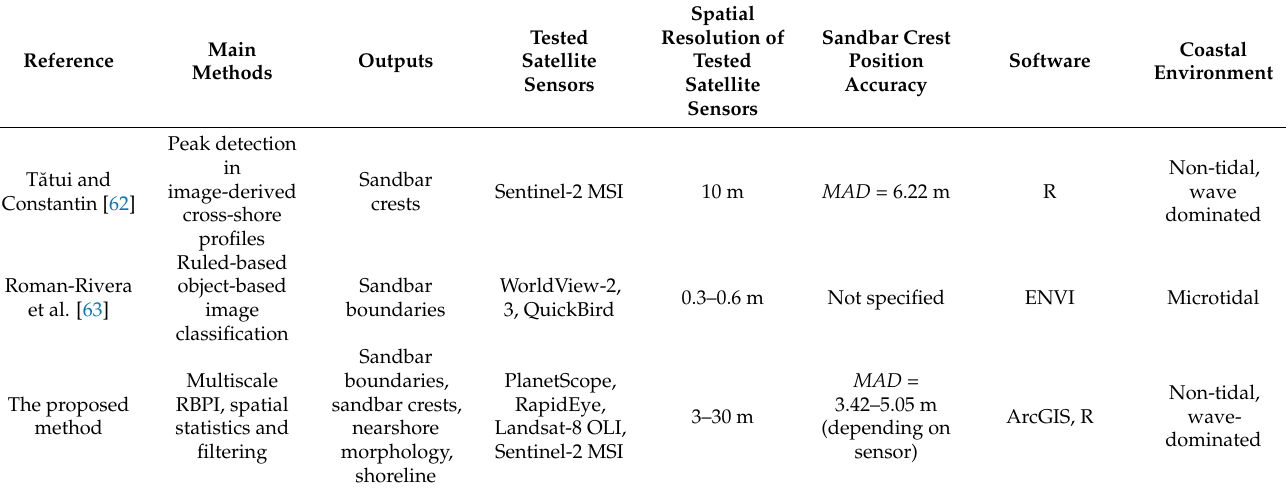
Table 3. A comparison of the proposed method to other automated and semi-automated methods of sandbar extraction in optical satellite